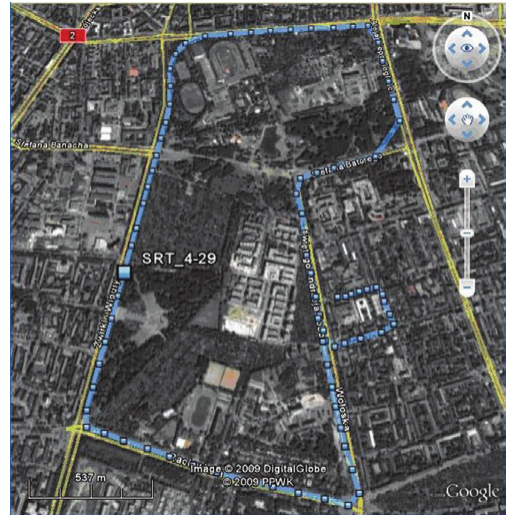
fig. 6. Location of the measurement points obtained from the GPS